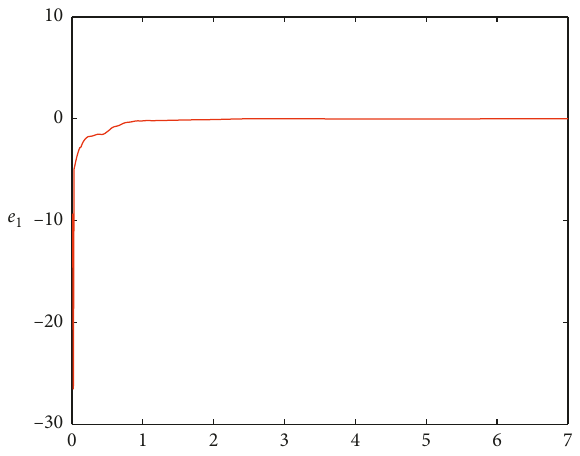
Figure 4: Combination synchronization errors e